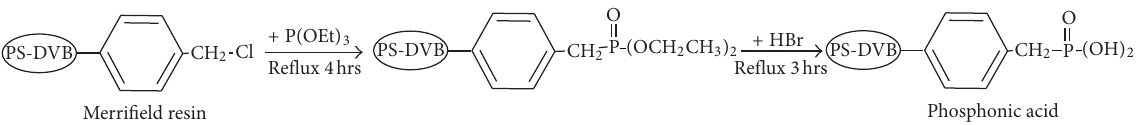
F 1: Scheme for synthesis of methylene phosphonic acid graed polystyrene resin beads.